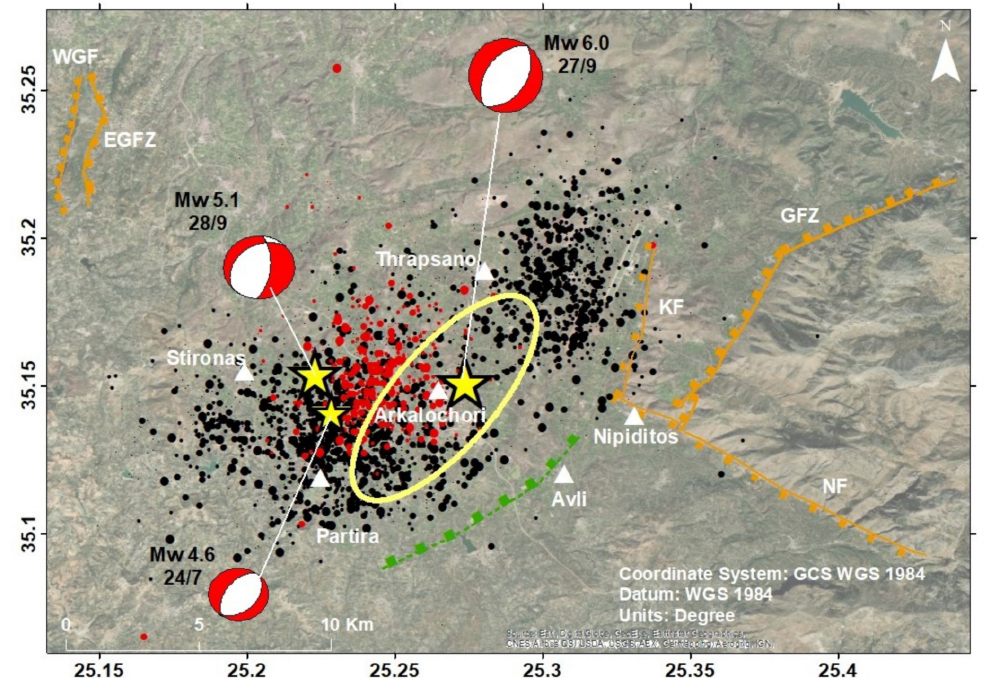
Figure 4. Foreshocks (red circles) and aftershocks (black circles) of the 27 September 2021 main shock (large star). Stars of small and medium sizes show the largest foreshock of 24 July 2021 and the largest aftershock of 28 September 2021, respectively. Key: star = earthquake epicenter; KF = Kastelli Fault; GFZ = Geraki Fault Zone; NF = Nipiditos Fault; WGF = West Giouchtas Fault; EGFZ = East Giouchtas Fault Zone; white triangle = settlement; the inferred buried KF segment is illustrated in green; ellipse shows the surface projection of the main shock slip area in the fault plane determined from the inversion of InSAR observations (see explanations in Section